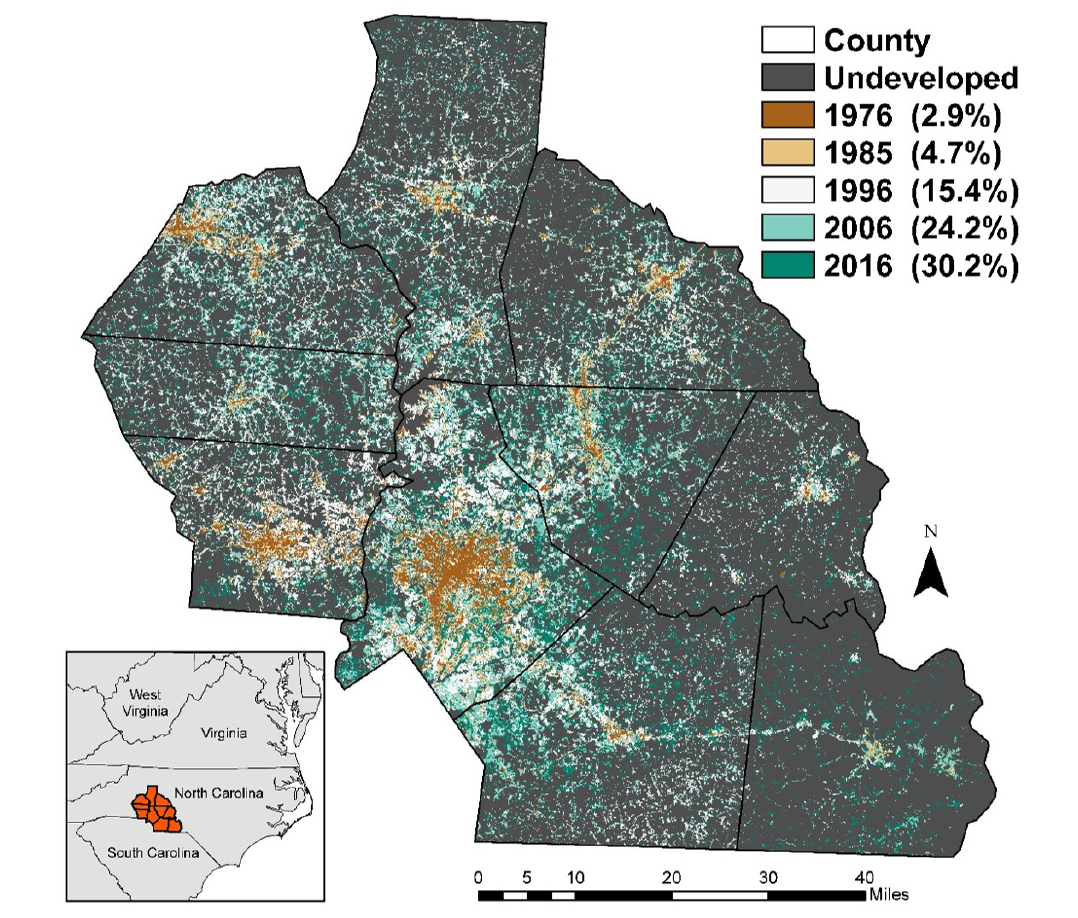
Figure 2. Ten county study extent showing urban development observed in 1976, 1985, 1996, 2006, and 2016 based on the vegetation-impervious surface soil (VIS) classification (methods). Percentages of the landscape are given for each year of observed urban